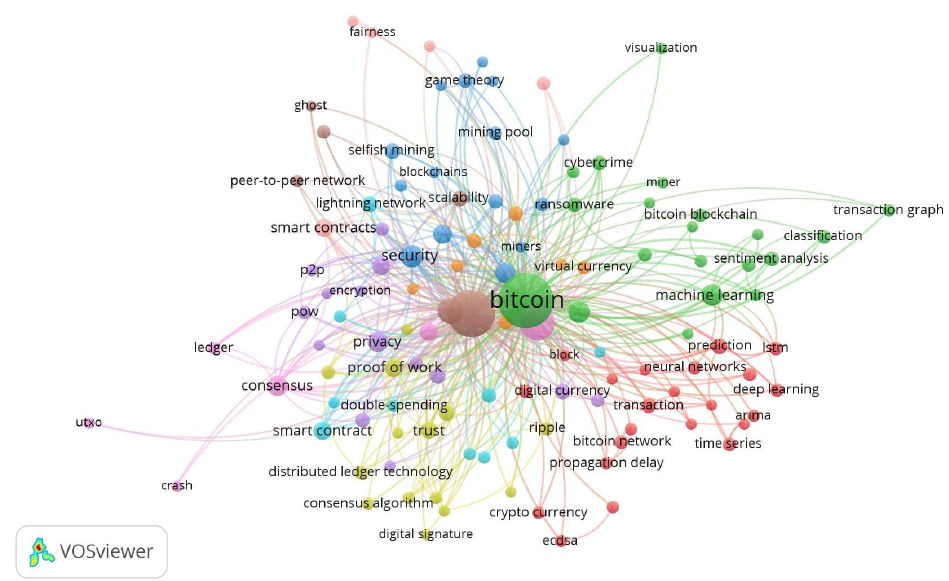
Figure 6. Keyword analysis of conference